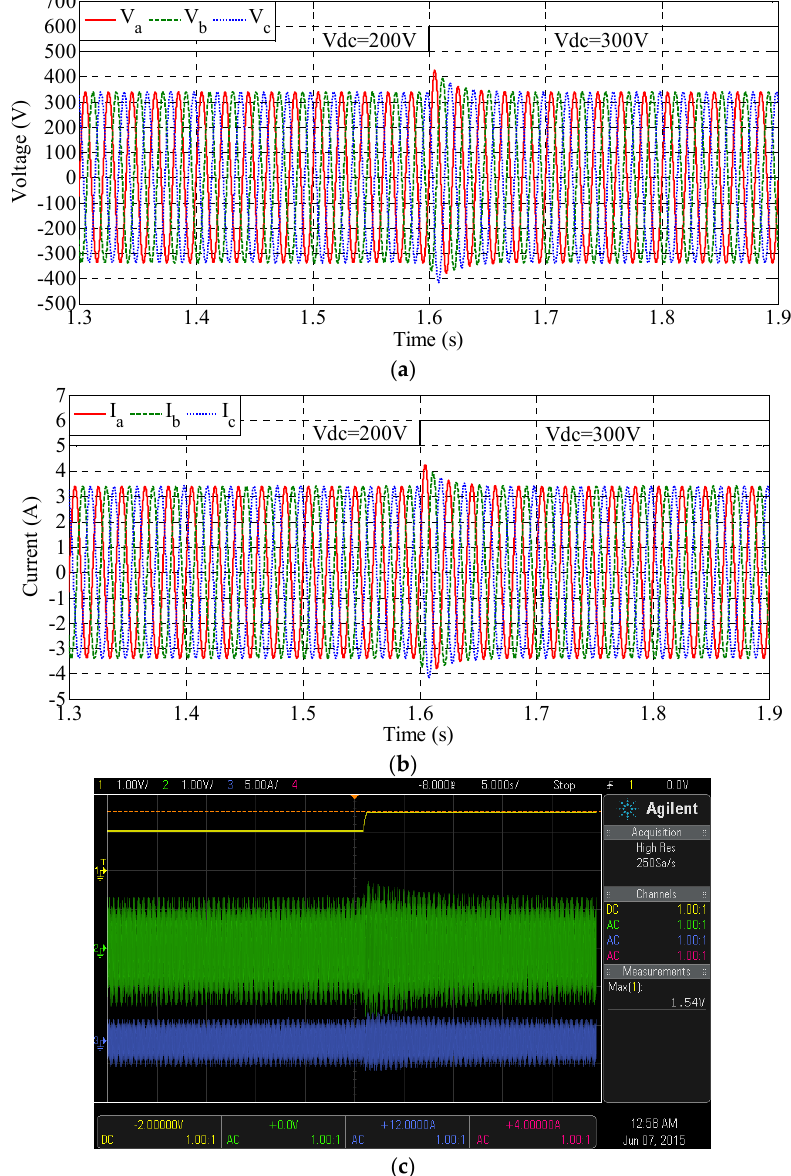
Figure 20. Output waveforms with V dc increasing from 200 V to 300 V with R load. ( a ) Simulation voltage waveforms; ( b ) simulation current waveforms; and ( c ) experimental voltage and current waveforms (Ch. 1, Ch. 2, and Ch. 3 for V dc , V a , and I a ,